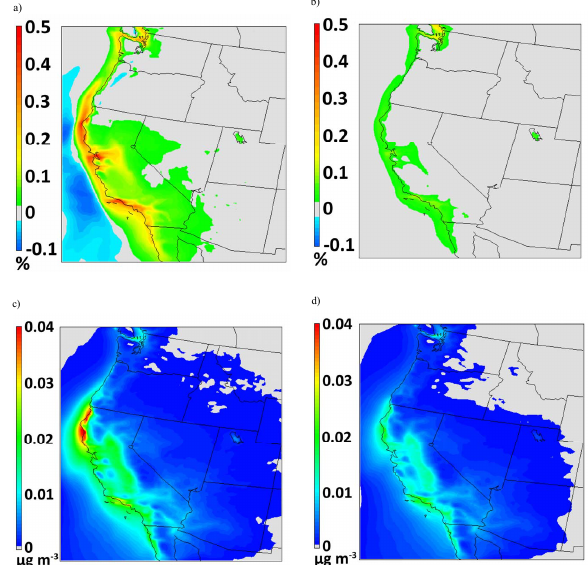
Fig. 5. Average percentage change in surface O 3 for the top-down (a) and bottom-up (b) simulations and average increase in sur- face SOA 2 . 5 concentrations concentration for the top-down (c) and bottom-up (d) simulations due to marine emissions from 1 June to 31 August